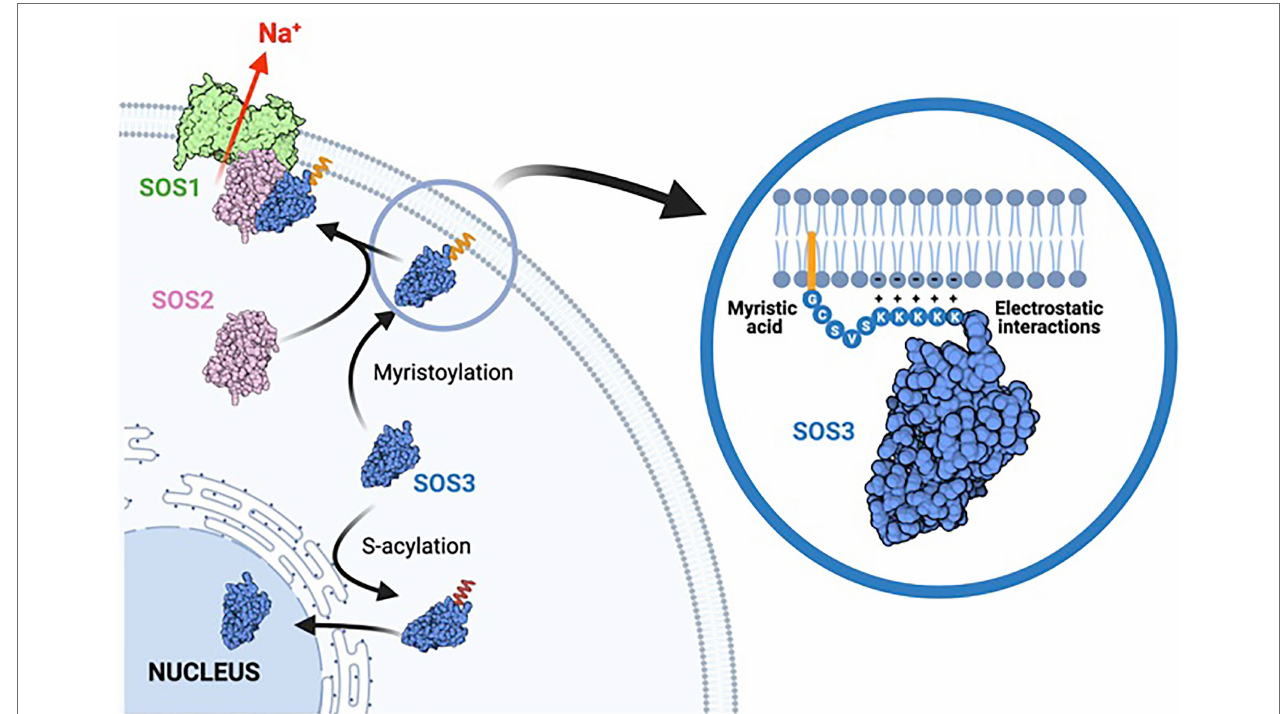
FIGURE 9 | Model of acylation-dependent SOS3 localization. Co-translational N -myristoylation of SOS3 results in the recruitment of the SOS2-SOS3 kinase complex to the plasma membrane for the phosphorylation and activation of SOS1 protein, thereby leading to sodium efflux and salt tolerance. The poly-lysine tract adjacent to the acylation sites reinforces the attachment of SOS3 to the plasma membrane by forming salt-bridges with the polar heads of phospholipids. By contrast, S-acylation commands the nuclear trafficking of SOS3 toward the nucleus. Cytosolic SOS3 may be either non-acylated as depicted or have the myristic residue concealed within the protein structure. We suggest that SOS3 is de-acylated when entering the nucleus to remain soluble in the